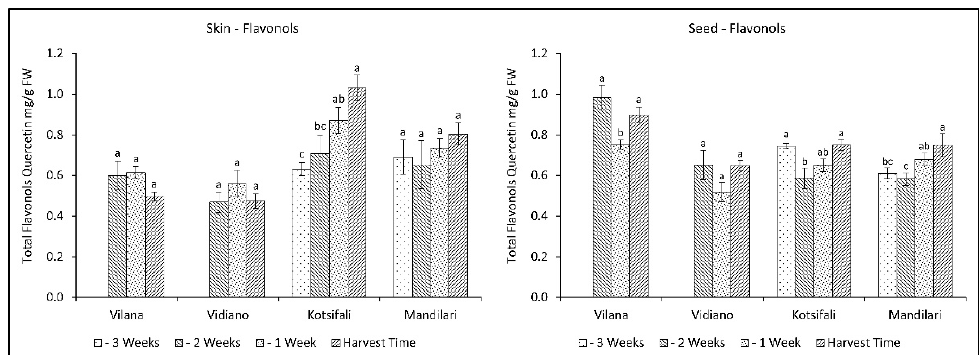
Figure 6. Skin and seed total flavonols content (mg QE g −1 FW) of Vilana, Vidiano, Kotsifali and Mandilari cultivars during ripening. The error bars represent the standard errors of the means. Different letters indicate statistically significant differences among weeks, according to Duncan’s multiple range test ( p ≤ 0.05).